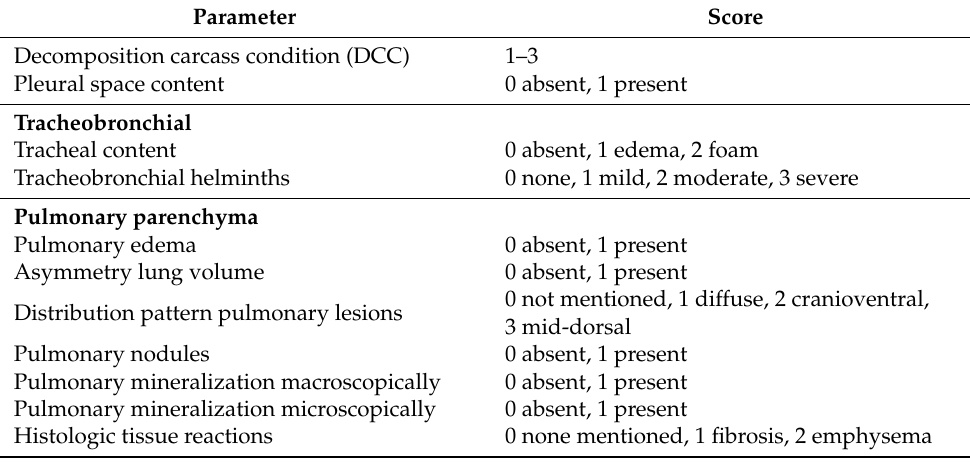
Table 2. Conventional necropsy report